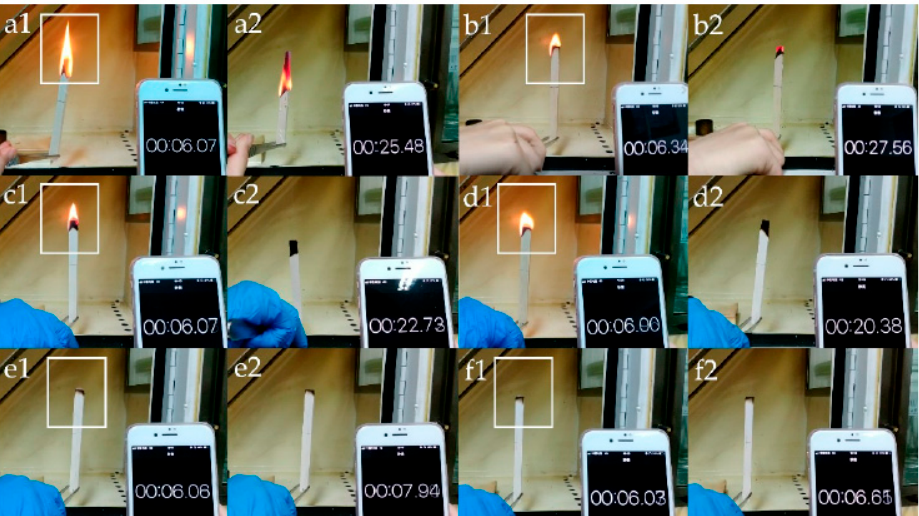
Figure 33. Propensity for flame burning of wood and the coated samples: ( a1 , a2 ) original wood; ( b1 , b2 ) chitosan-coated sample; ( c1 , c2 ) chitosan sodium phytate-coated sample; ( d1 , d2 ) chitosan / sodium phytate / nano-ZnO-coated sample; ( e1 , e2 ) chitosan / sodium phytate / nano-TiO 2 -coated sample; ( f1 , f2 ) chitosan / sodium phytate / nano-TiO 2 -ZnO-coated sample. Reprinted from [57] under CC BY 4.0 license.